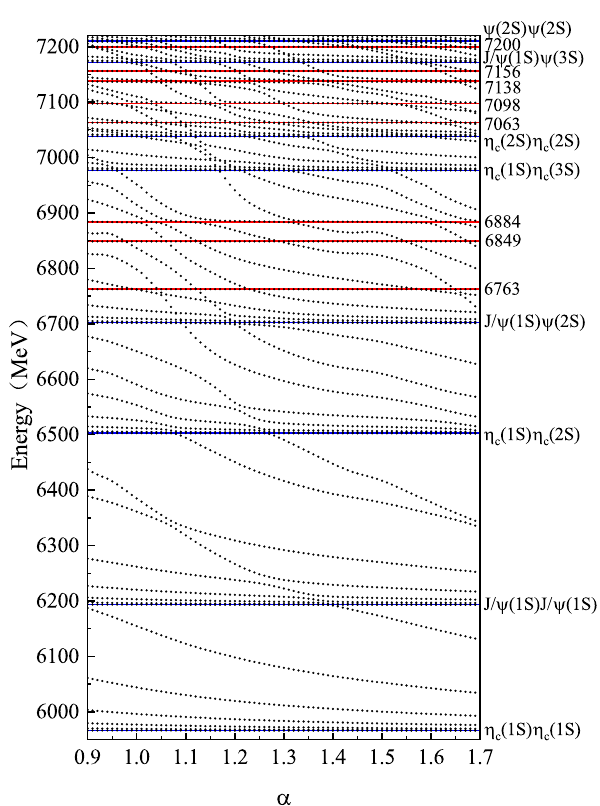
Figure 9. The stabilization plots for the energies of the states for J PC = 0 ++ obtained by considering the full-channel couplings with respect to the scaling factor α .